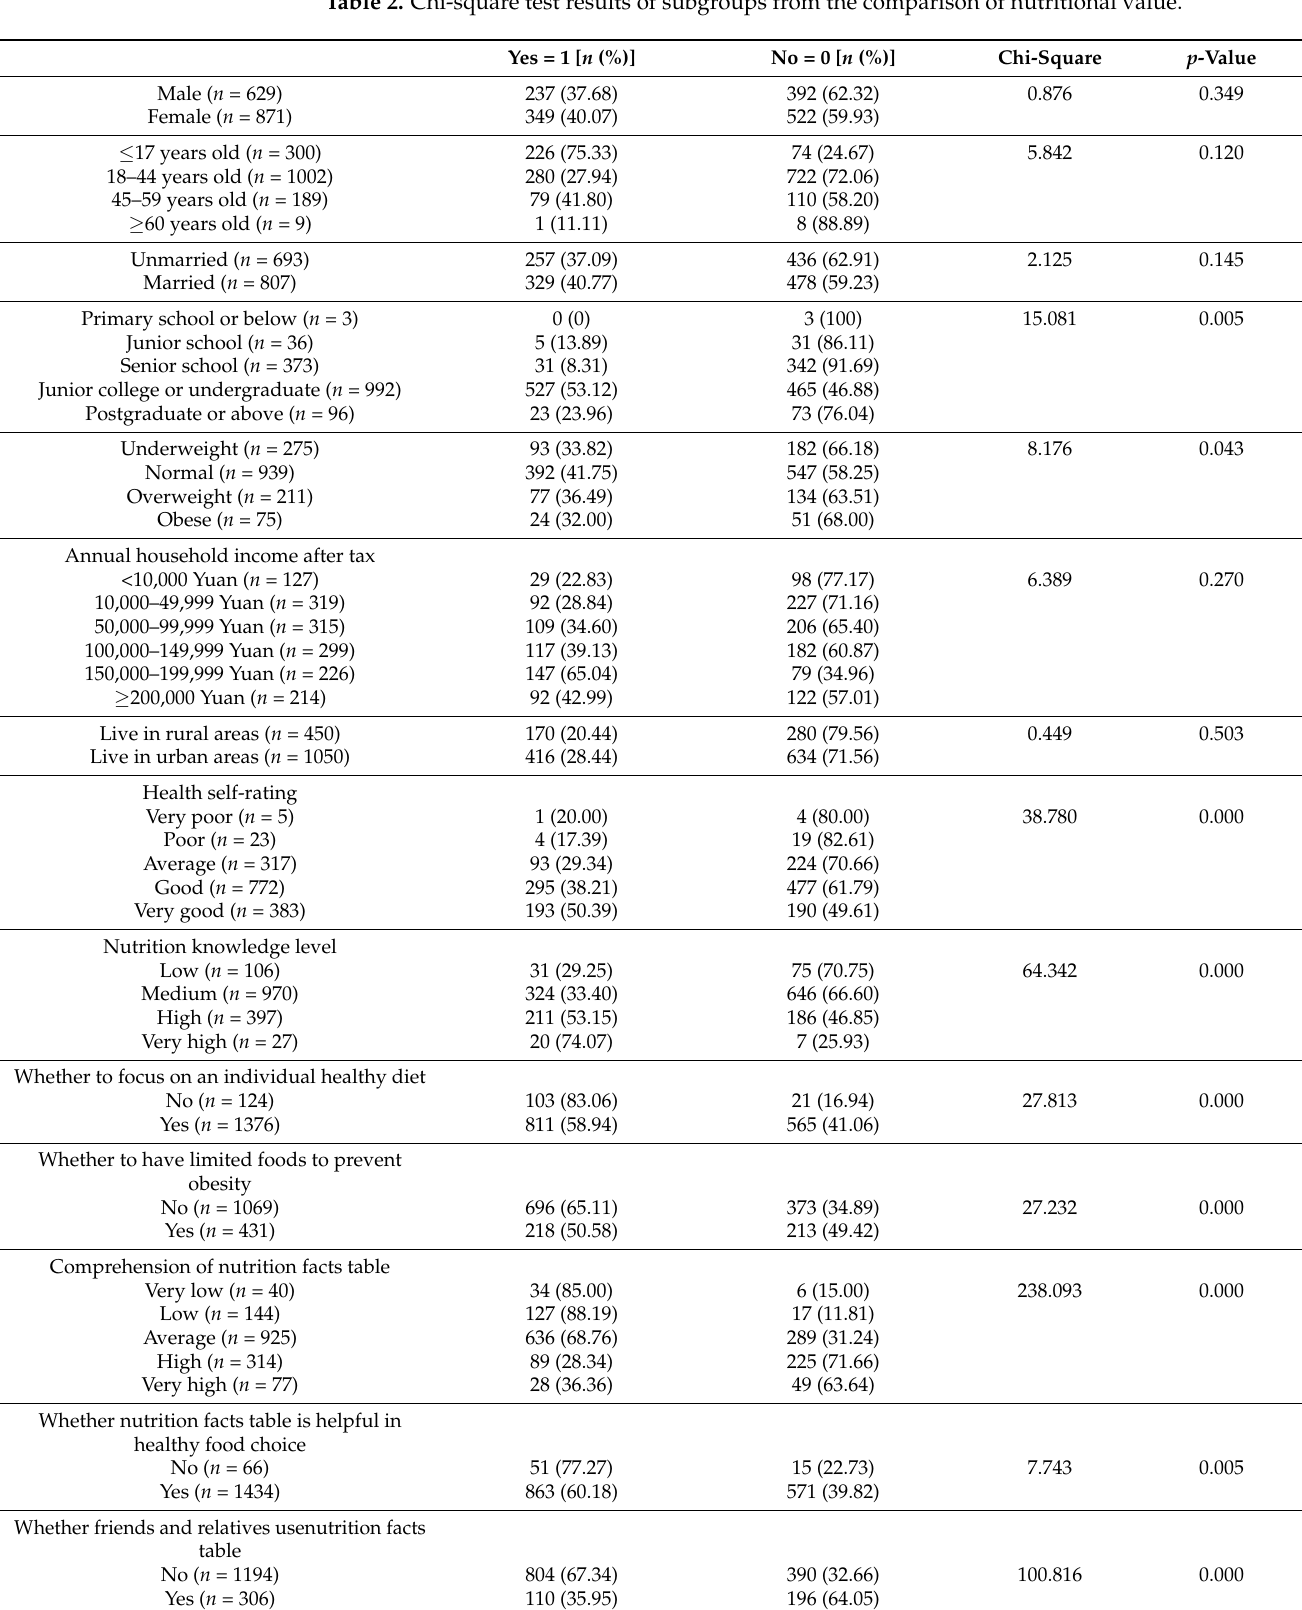
Table 2. Chi-square test results of subgroups from the comparison of nutritional